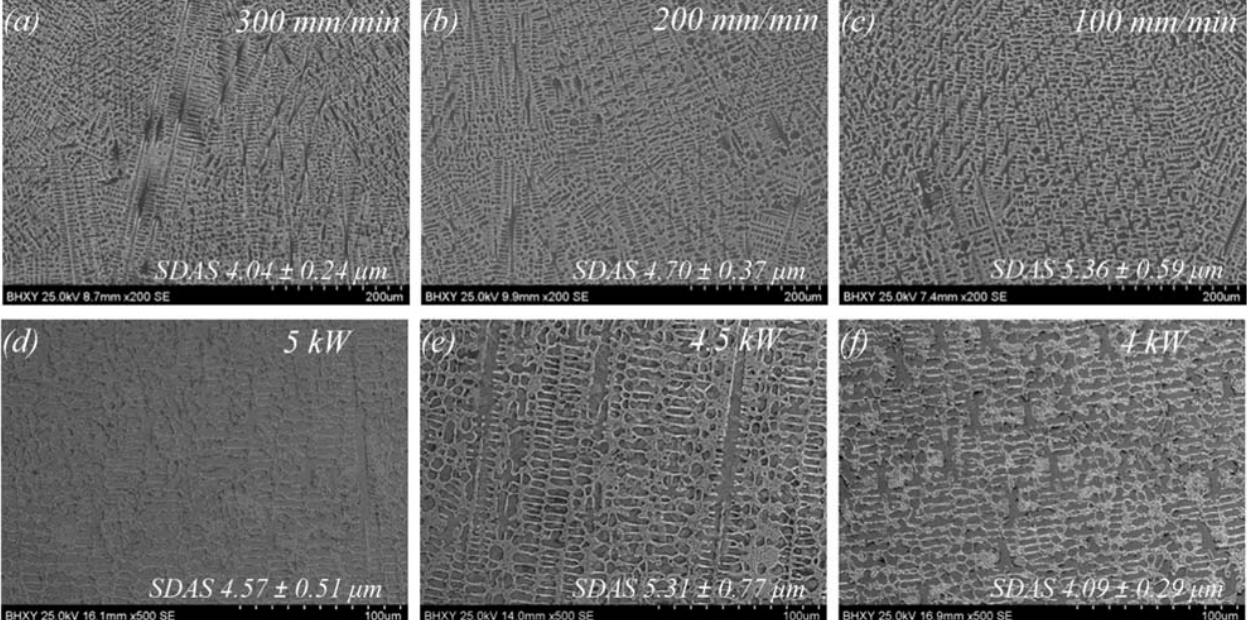
Figure 5. SEM morphologies of Ni35 coatings fabricated at different processing conditions: ( a ) 5 kW, 300 mm/min; ( b ) 5 kW, 200 mm/min; ( c ) 5 kW, 100 mm/min; ( d ) 5 kW, 200 mm/min; ( e ) 4.5 kW, 200 mm/min; and ( f ) 4 kW, 200 mm/min.